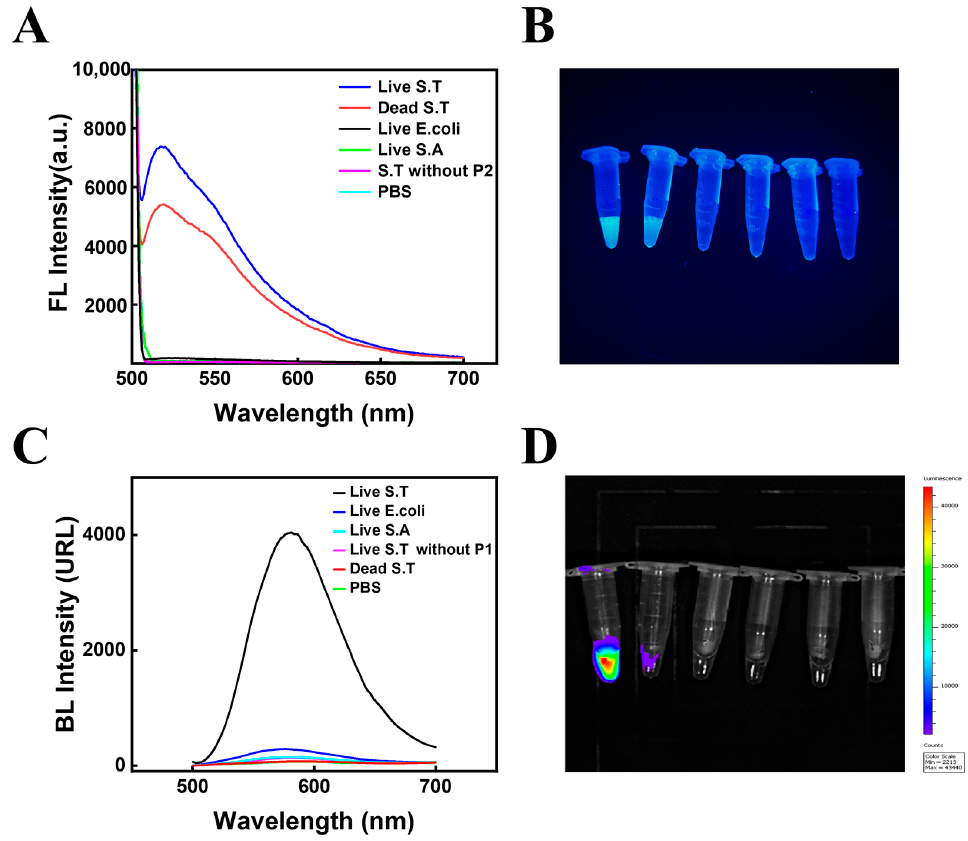
Figure 3. The fluorescence feasibility of the biosensor ( A ) and its physical diagram of fluorescence luminescence ( B ). The bioluminescence feasibility of the biosensor ( C ) and its ATP bioluminescence imaging ( D ). (The concentration of all bacteria was 10 8 CFU . mL − 1 ).